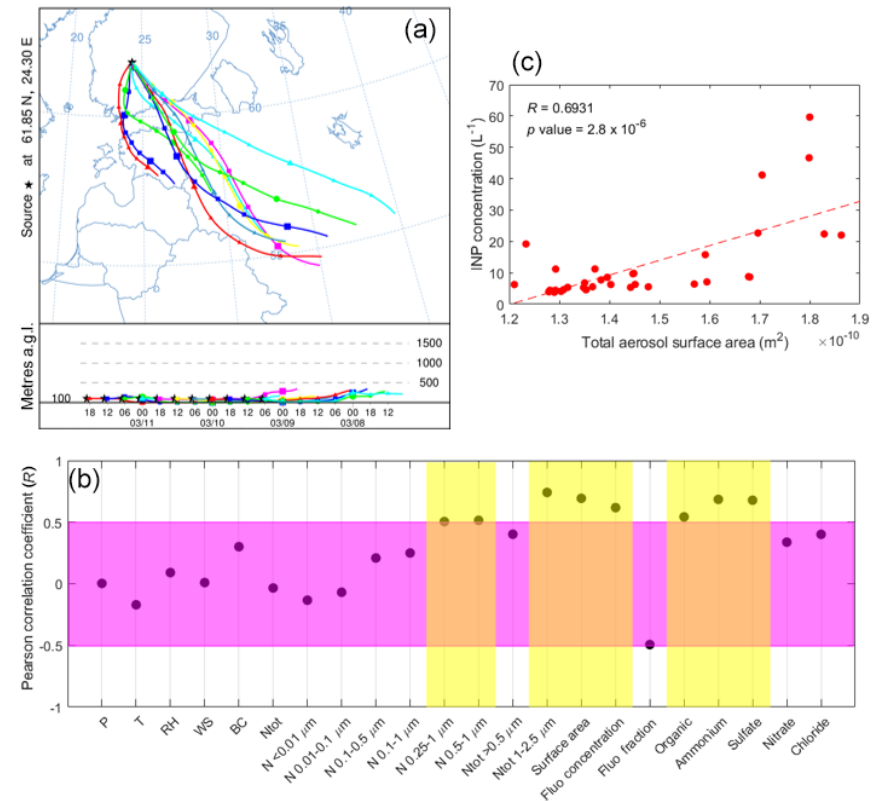
Figure 6. All results shown for 9–11 March 2018. (a) Backward trajectories calculated using the HYSPLIT model, extending 48h back in time. (b) Pearson correlation coefficients of the linear correlation between the [INP] and various meteorological and particle parameters. Magenta shading denotes the area of weak, if any, correlation ( − 0 . 5 < R < 0 . 5). Yellow shading denotes parameters for which the correlation with the corresponding [INP] is better than weak ( R > 0 . 5) and statistically significant at the 95% confidence interval ( p value < 0 . 05). (c) The [INP] as a function of total particle surface